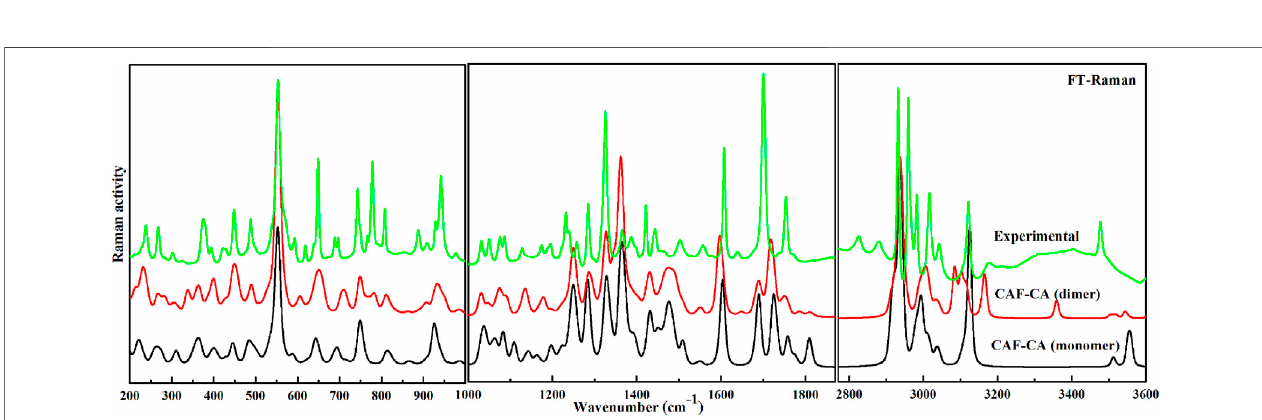
FIGURE 4 | Experimental and calculated (scaled) Raman scattering spectra of monomer and dimer model of cocrystal in the region 200 – 999 cm − 1 , 1,000 – 1870 cm − 1 and 2,770 – 3,600 cm − 1 .